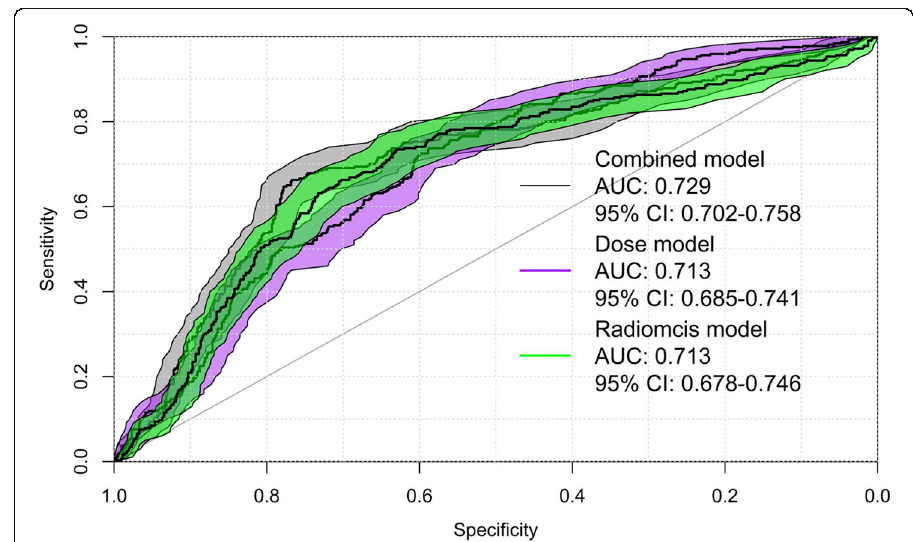
Fig. 4 ROC curves for overall response (OR) at first follow-up with the combined model, radiomics alone model, and dose alone model